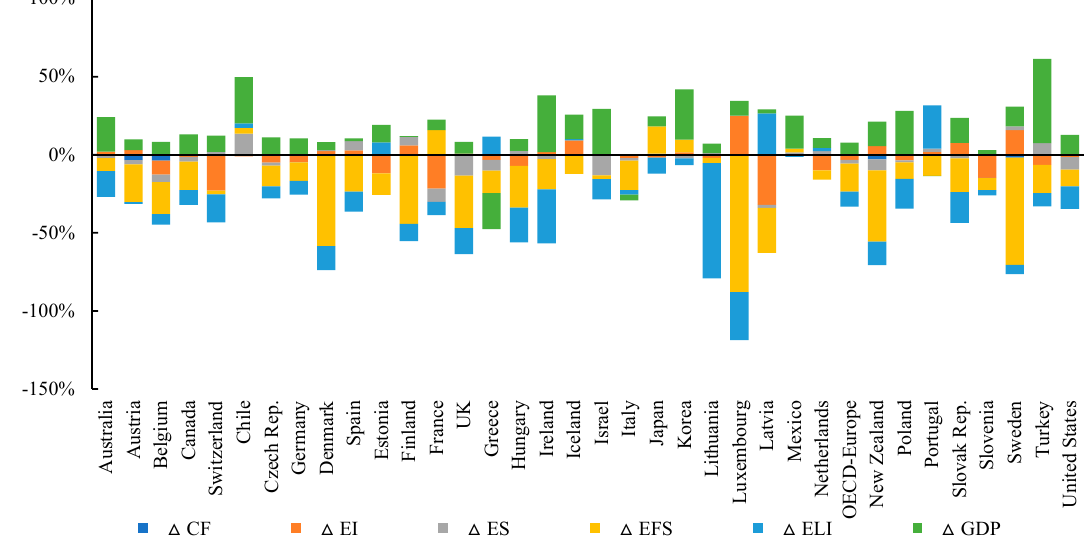
Figure 5. Decomposition results of CO 2 emission in power sector by driving factors, 2008–2017.